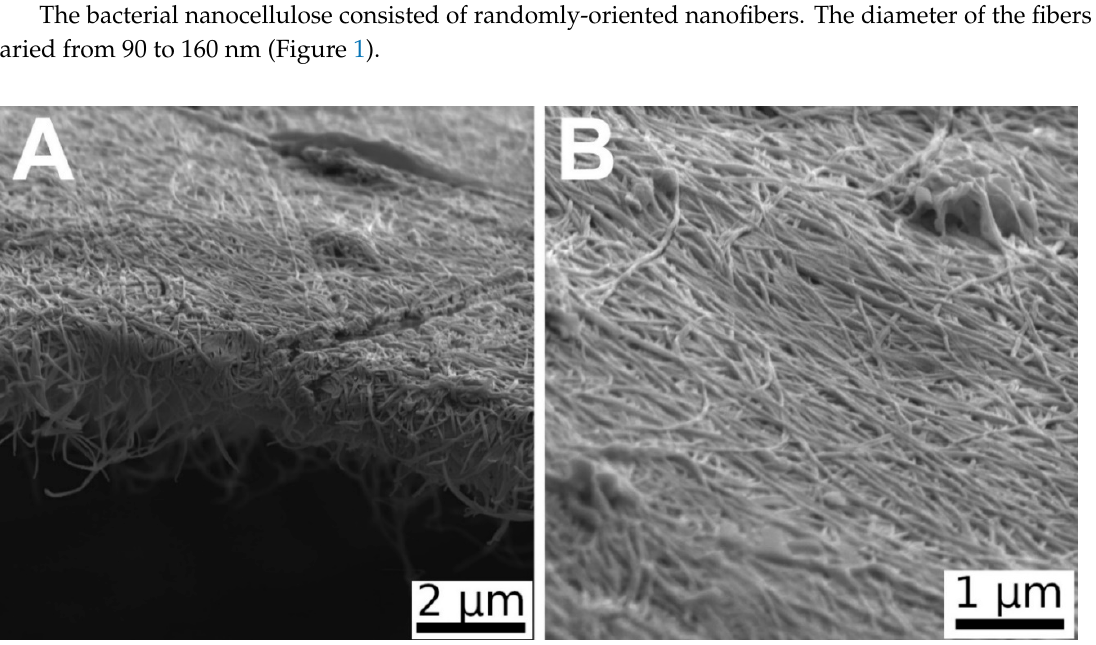
Figure 1. SEM images of bacterial nanocellulose cultivated for 7 days and then washed and dried with 96% ethanol. Side view ( A ) and view from above ( B ). Magnification 20× (A) and 40× (B).